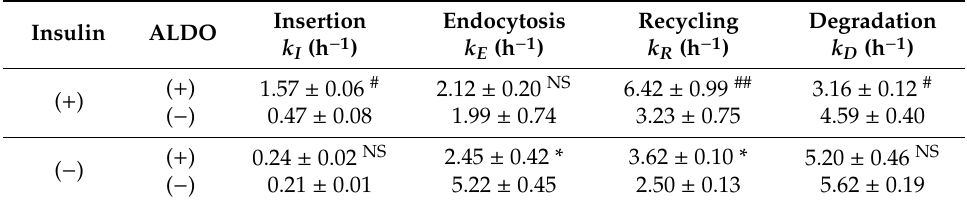
Table 1. Evaluated values of ENaC’s trafficking rates in the presence and absence of 100 nM insulin with and without 1 µM aldosterone treatment for 20 h.